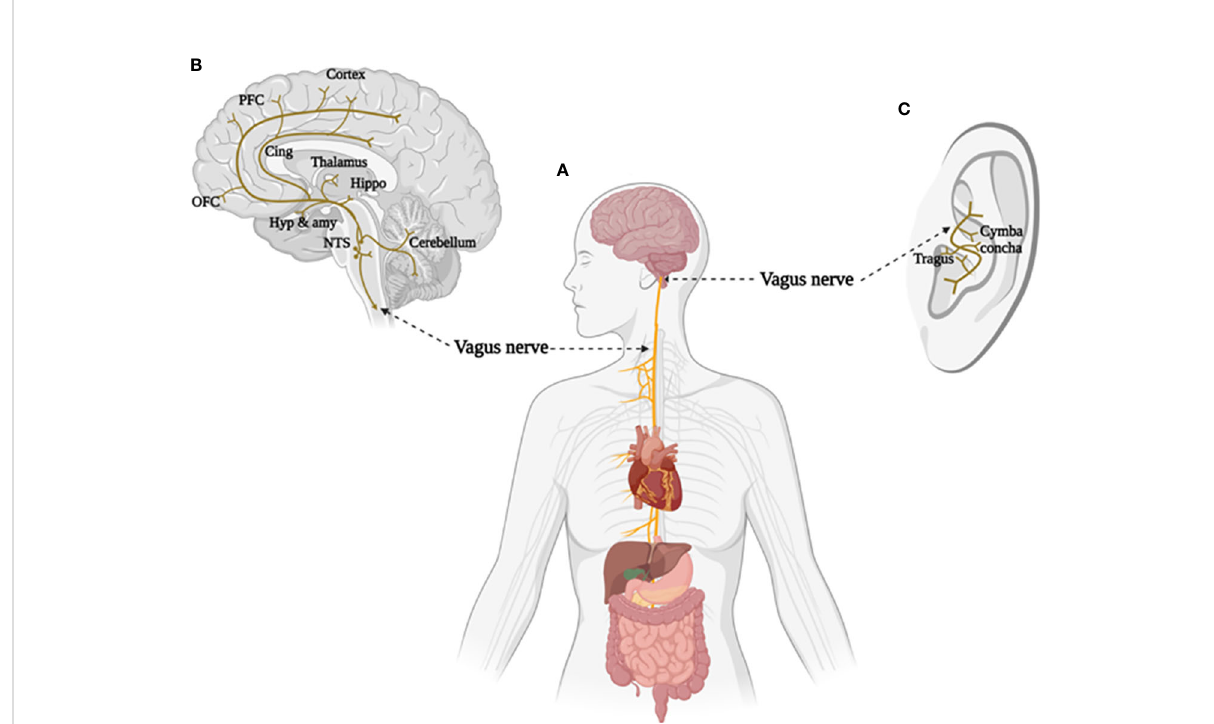
FIGURE 1 The brain and body projections of vagus nerve. (A) Illustration of the connection between brain and major body organs via the vagus nerve. (B) Areas of the brain involved in the afferent vagal pathway. Nucleus tractus solitarius (NTS), hypothalamus (Hyp), amygdala (amy), hippocampus (Hippo), cingulate cortex (Cing), orbital frontal cortex (OFC), and prefrontal cortex (PFC). (C) Distribution of the vagus nerve in the external ear. Created with